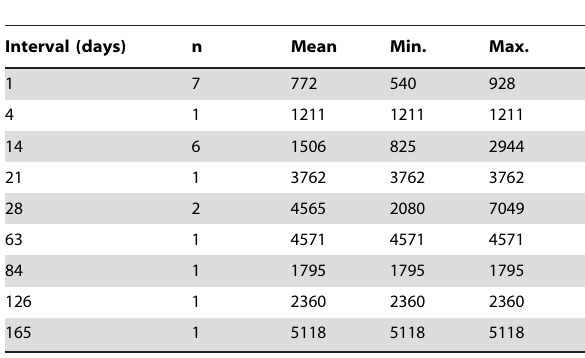
Table 1. Intervals used for accumulation studies and the number of items found in in each interval category (rounded to the nearest integer) (n= the number of replicate surveys for that